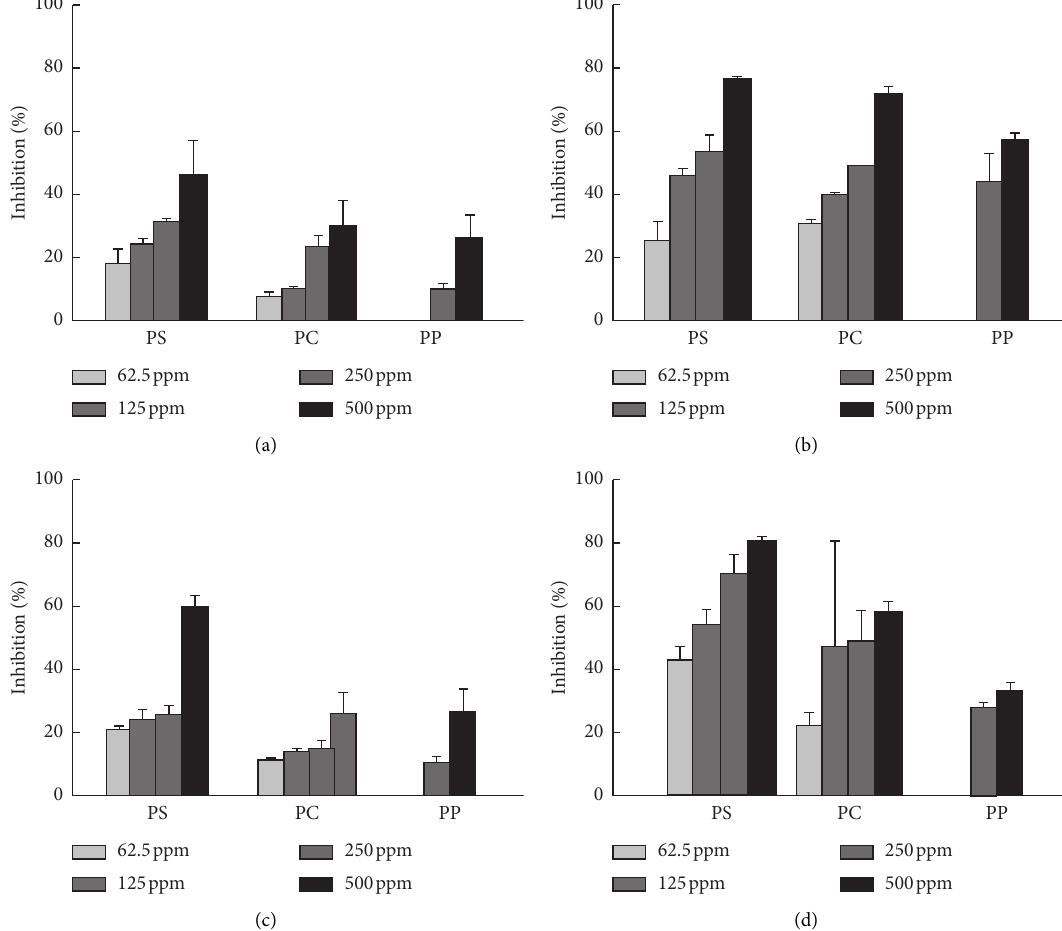
Figure 3: In vitro antifungal activity of the isolated limonoids 2 , 3 , 6 , and 8 against oomycete Phytophthora strains. PS: Phytophthora spp.; PC: Phytophthora capsici ; PP : Phytophthora palmivora . (a) Compound 2 . (b) Compound 3 . (c) Compound 6 . (d) Compound 8